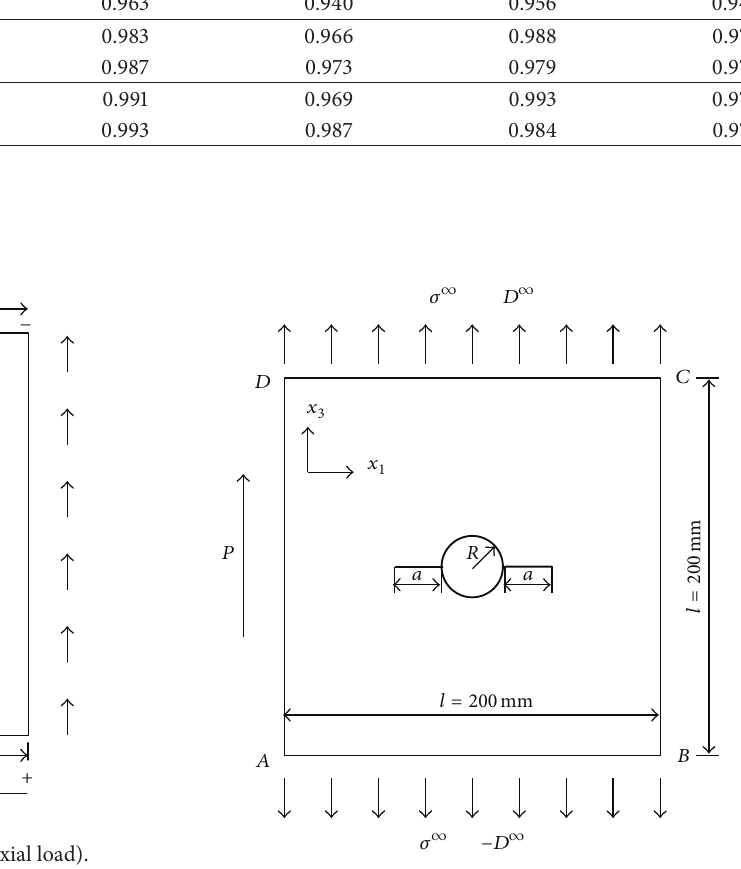
Figure 9: Piezoelectric model with a hole with cracks.